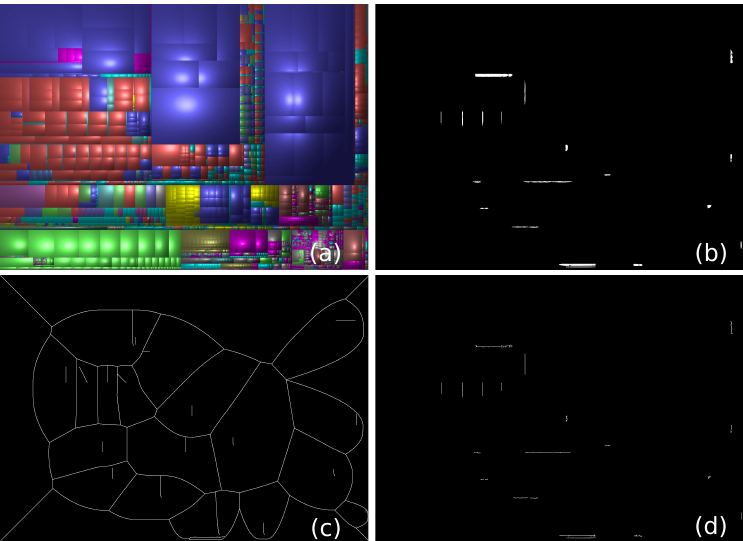
Figure 2. Adaptively encoding upper vs. lower threshold-sets. ( a ) Input image. ( b ) One threshold-set of the luminance channel in ( a ) for intensity i = 83. ( c ) The generated medial axis of T ↑ generated medial axis of T 83 ↓ , which is far less complex than, and thus preferred to, T ↑